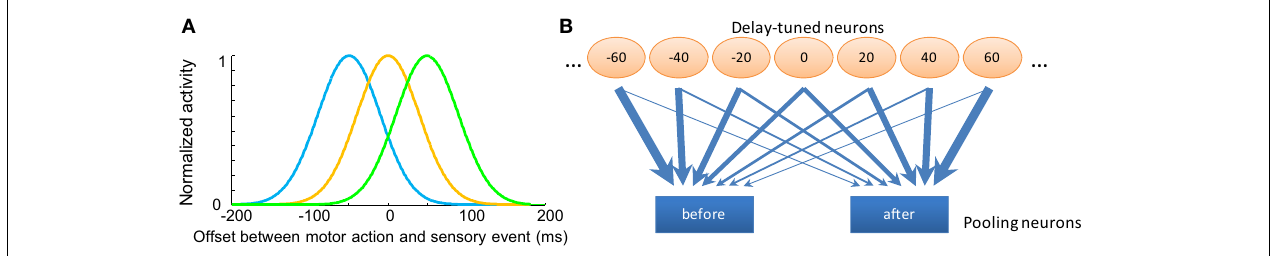
rectangles represent pooling modules with different input weight patterns from the lower level neurons; they selectively receive stronger synapses from neurons coding for “before” or “after,” respectively.The width of the arrows indicates the strength of the weights.These pooling modules compete with each other to reach a decision; the one with stronger activity will represent the final judgment of temporal